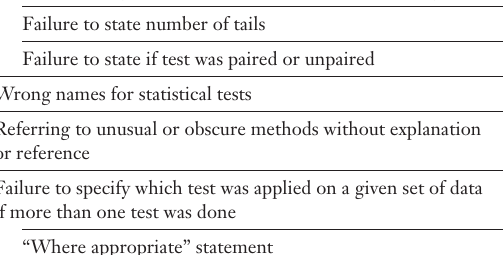
Errors related to the documentation of statistical methods